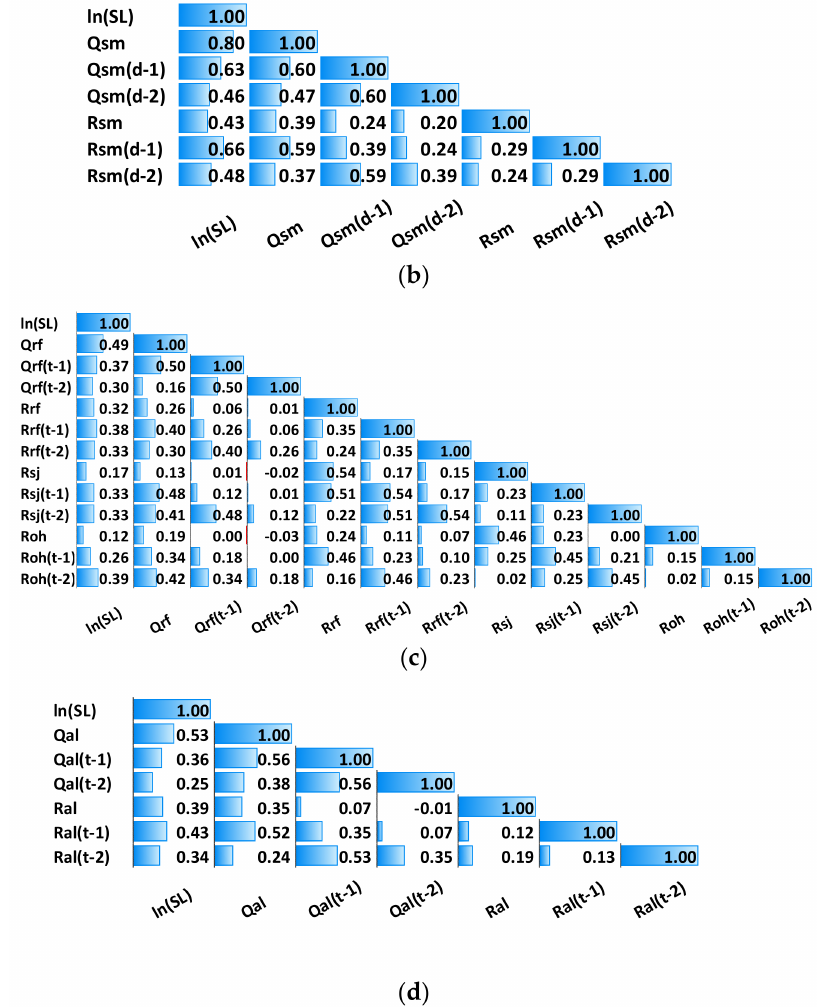
Figure 3. Correlation matrix of the variables. ( a ): Correlation matrix of the variables at Aguibat Ziar (az) station; ( b ): correlation matrix of the variables at Sidi Mohammed Cherif (sm) station; ( c ) correlation matrix of the variables at Ras Fathia (rf) station (sm); ( d ): correlation matrix of the variables at Ain Loudah (al) station. The Napierian logarithm of the suspended sediment load ln(SSL) is positively correlated with discharges and rainfalls in the basin. The rainfalls and flow discharge at (day-i) are more